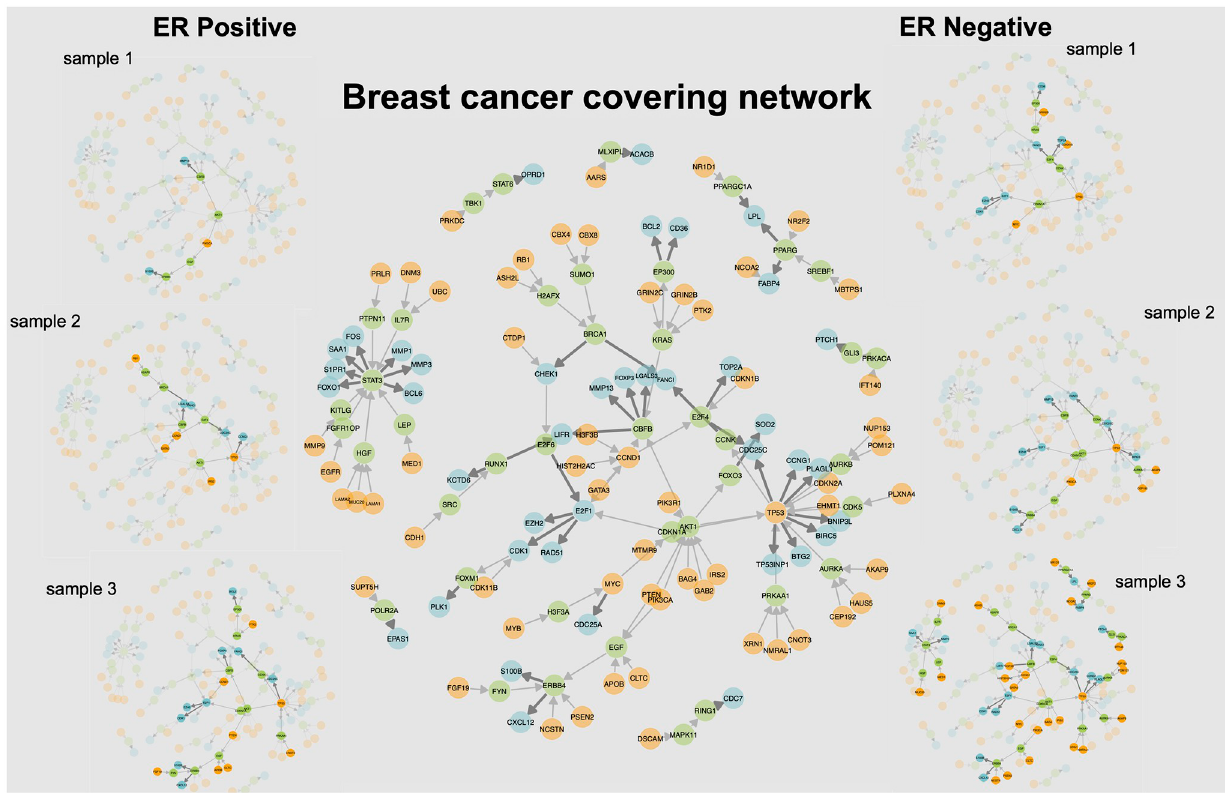
Fig 2. Networks of pair coverings in breast cancer. The network shown in the center depicts one covering of breast cancer samples by STPs, with source genes in orange, target genes in blue, and intermediary link genes in green. The thin and thick edges represent, respectively, the two types of relationships: “controls state change of” and “controls expression of” as designated in Reactome [19]. On the left are presented a selection of covering realizations for three ER-positive samples, where aberrant STPs are highlighted, while and on the right, three ER-negative samples samples are shown. The samples have different realizations over the covering network, and are ranked (top to bottom) by the number of events they exhibit. The sample networks demonstrate the inter-sample heterogeneity among the source and target realizations.